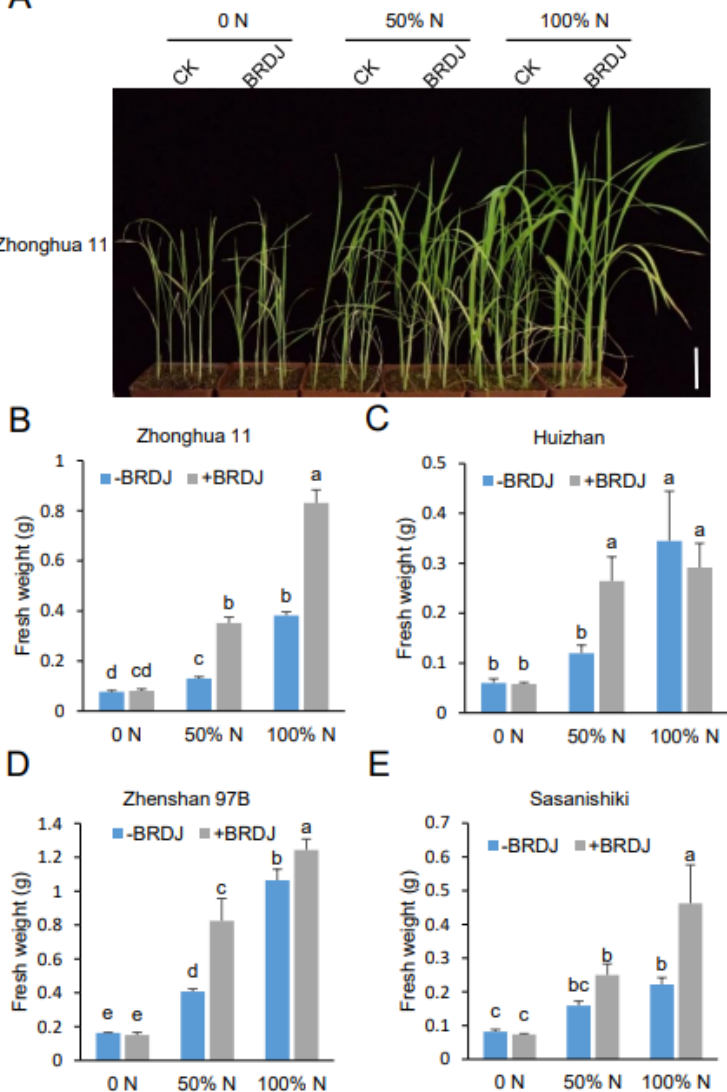
Figure 2. Plant growth-promoting activity of BRDJ on representative rice cultivars. ( A ) Representative images of Zhonghua 11 plants inoculated with BRDJ or mock growing on vermiculite/perlite mix. Scale bar, 5cm. ( B – E ) Fresh weight of Zhonghua 11 ( B ), Huizhan ( C ), Zhenshan 97B ( D ), Sasanishiki ( E ) measured at 45 dpi. For each group, 18 plants were measured. Values are presented as means ± SD. Different letters indicate significant differences among treatments (Fisher’s Least Significant Difference test, p < 0.05).